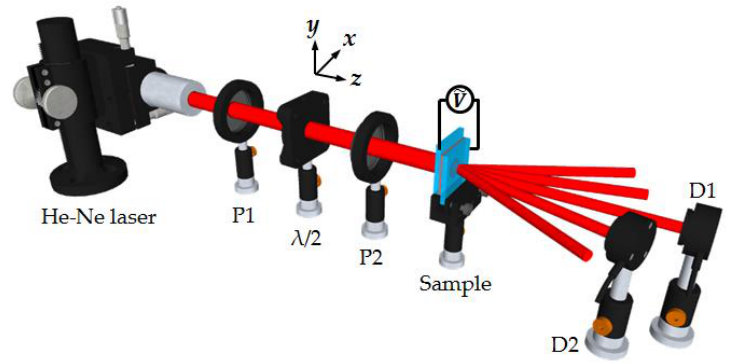
Figure 1. Schematic illustration of the experimental set-up. P1, P2: polarizers; λ / 2: half-wave plate; D1, D2: detectors.